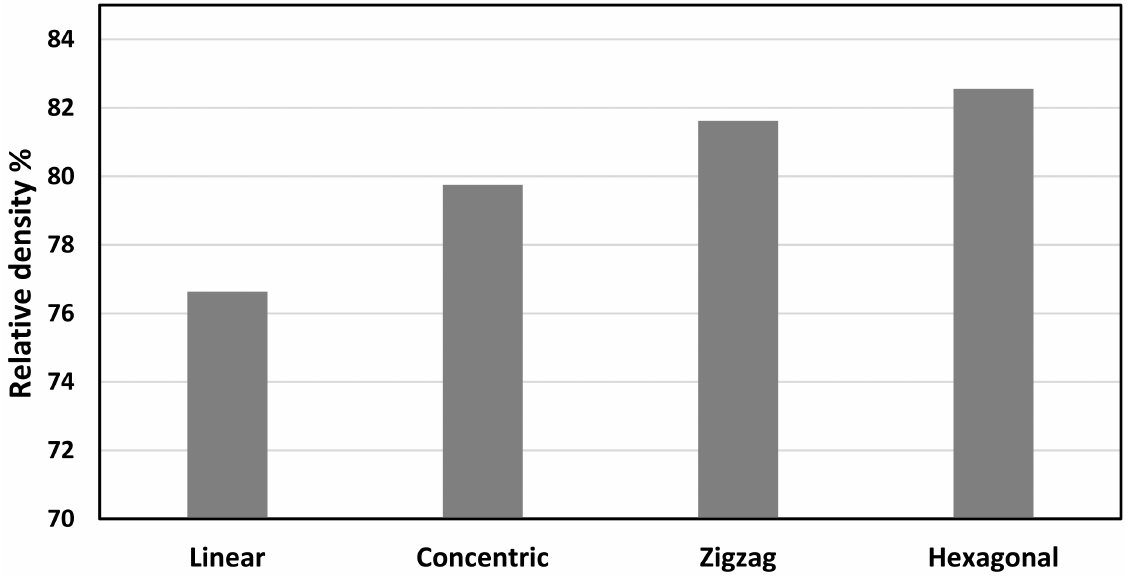
Figure 11. Relative densities for SiC samples printed with different scanning